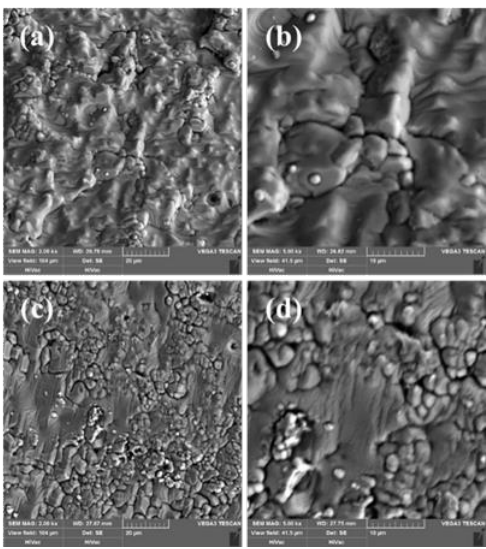
Figure 5. SEM images of ITO films deposited on the sapphire microrod before ( a,b ) and after ( c,d ) thermal annealing at 1000 °C.